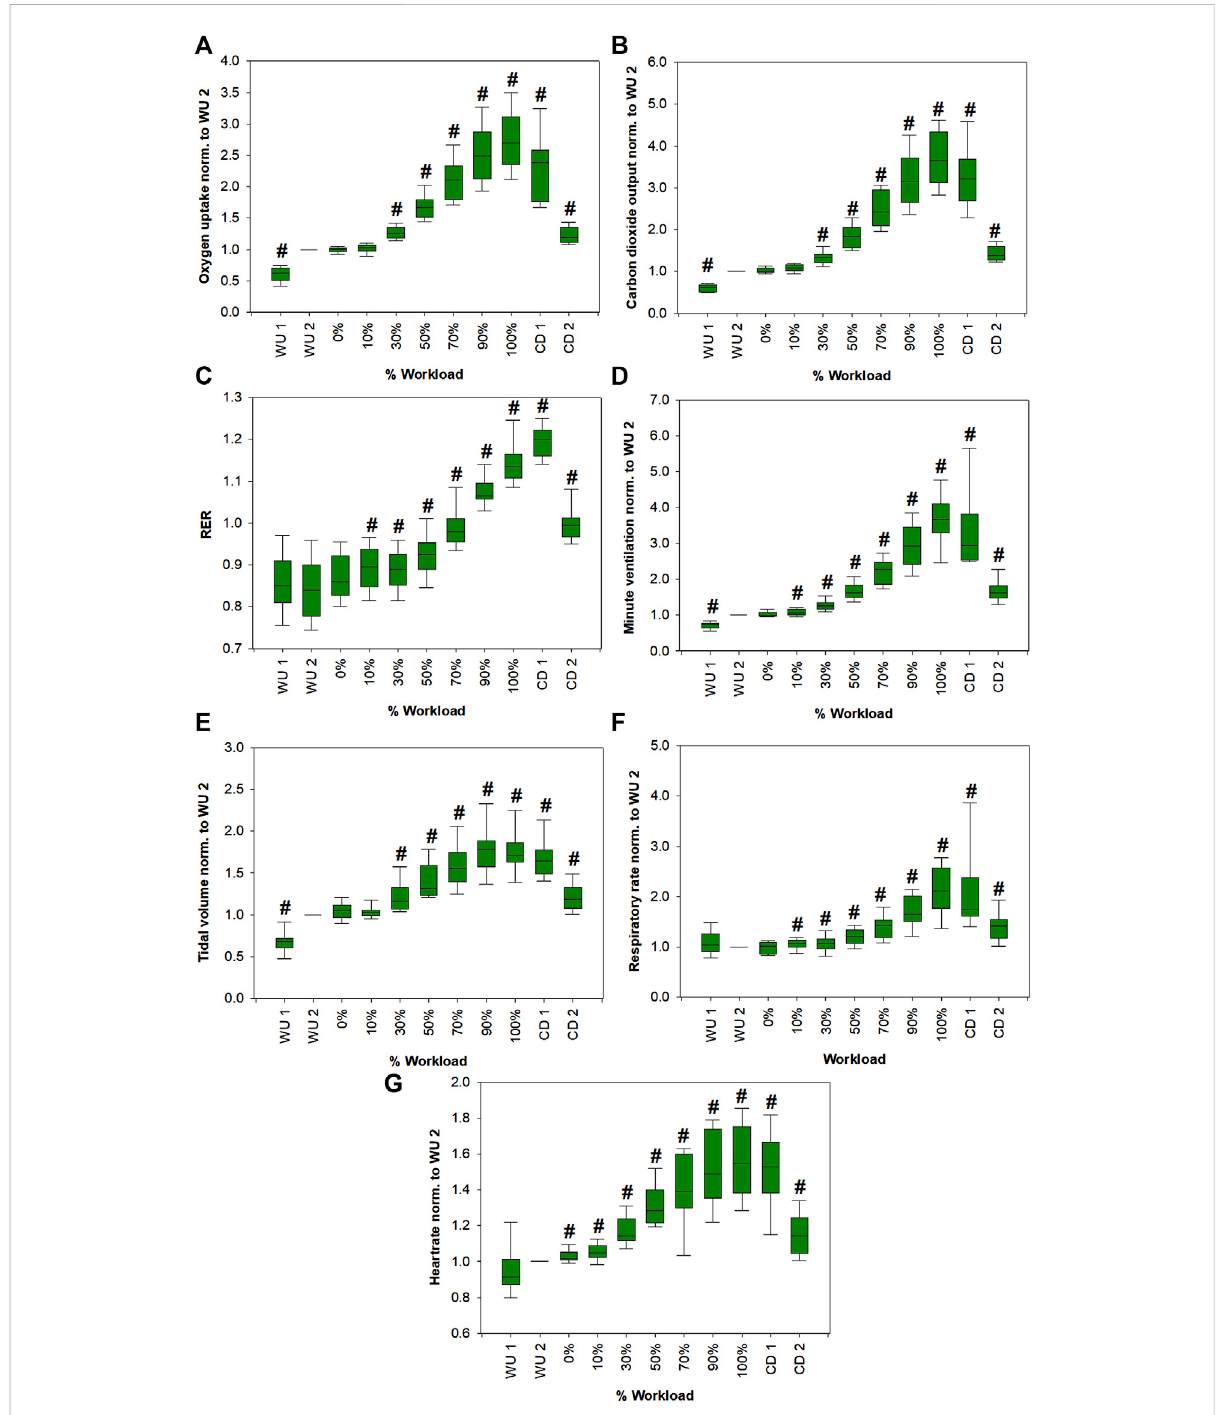
FIGURE 2 ChangesinVO2 (A) ,VCO2 (B) ,RER (C) ,VE (D) ,TV (E) ,RR (F) andHR (G) fromallvolunteersasafunctionoftherelativeworkload.ExceptforRER, absolute values of all parameters were normalized to respective values at the last minute of warm-up (WU 2) for emphasis of relative changes. Statistically signi fi cant changes (Friedman repeated measures ANOVA on ranks, Student-Newman-Keuls post-hoctest, p < 0.05; except for TV. Due to normal distribution, a one-way repeated measures ANOVA was performed, Student-Newman-Keuls post-hoc test, p < 0.05) compared to WU 2 are marked with a hash. Corresponding p -values are shown in Supplementary Table